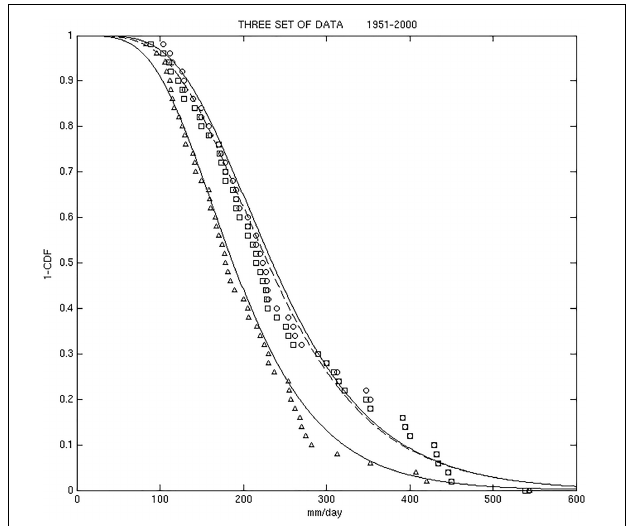
FIGURE 9 | Three set of data; original one (circle), second set (squares), third set (triangles). Yearly series. The continuous lines represent the fitting